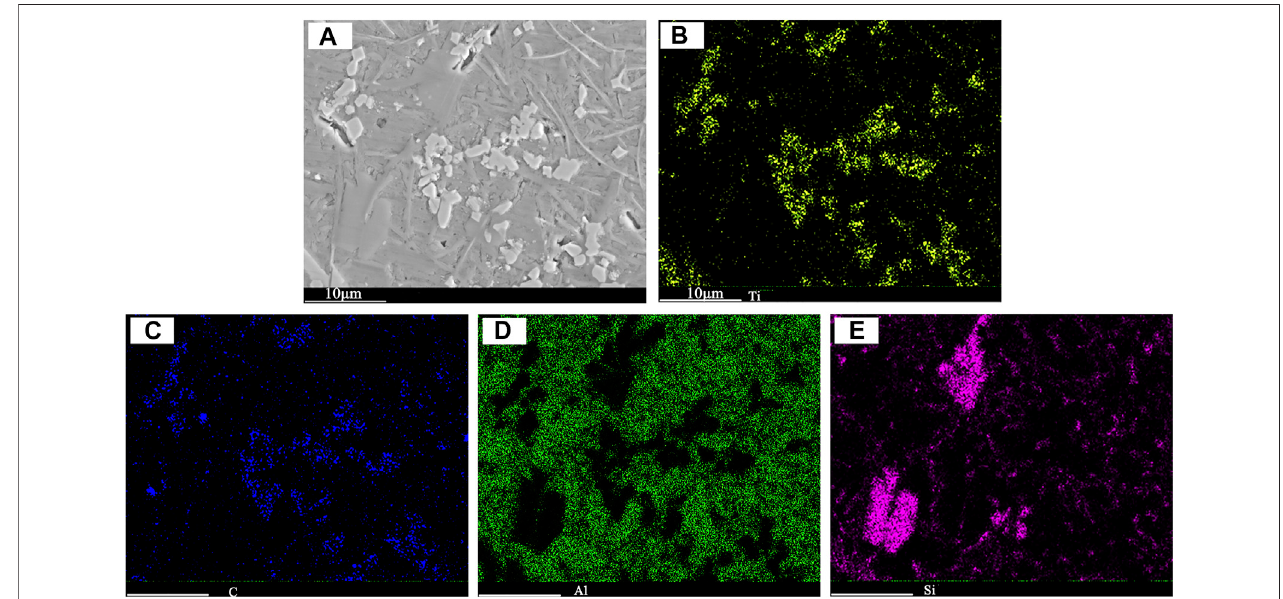
FIGURE 9 | Element distribution of SiCp/6061Al laser welding with Ti interlayer: (A) weld metal, (B) Ti, (C) C, (D) Al, (E) Si.